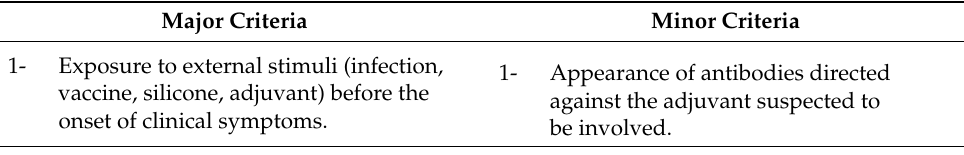
Table 1. The diagnostic criteria for ASIA syndrome divided into major and minor